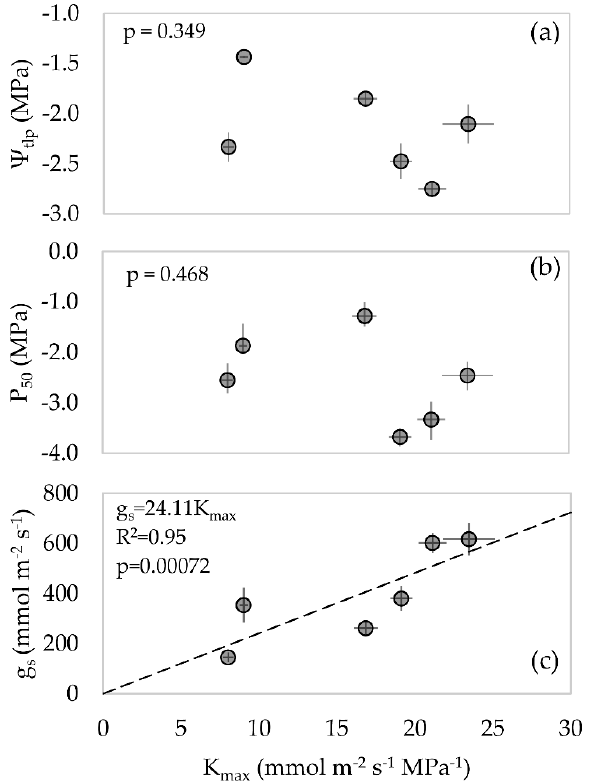
Figure 2. Relationship of K max with Ψ tlp ( a ), P 50 ( b ), and g s ( c ). Each point represents the mean per species ± standard error (n = 6). Vertical bars in Figure 3b represent the 95% confidence interval for P 50 .